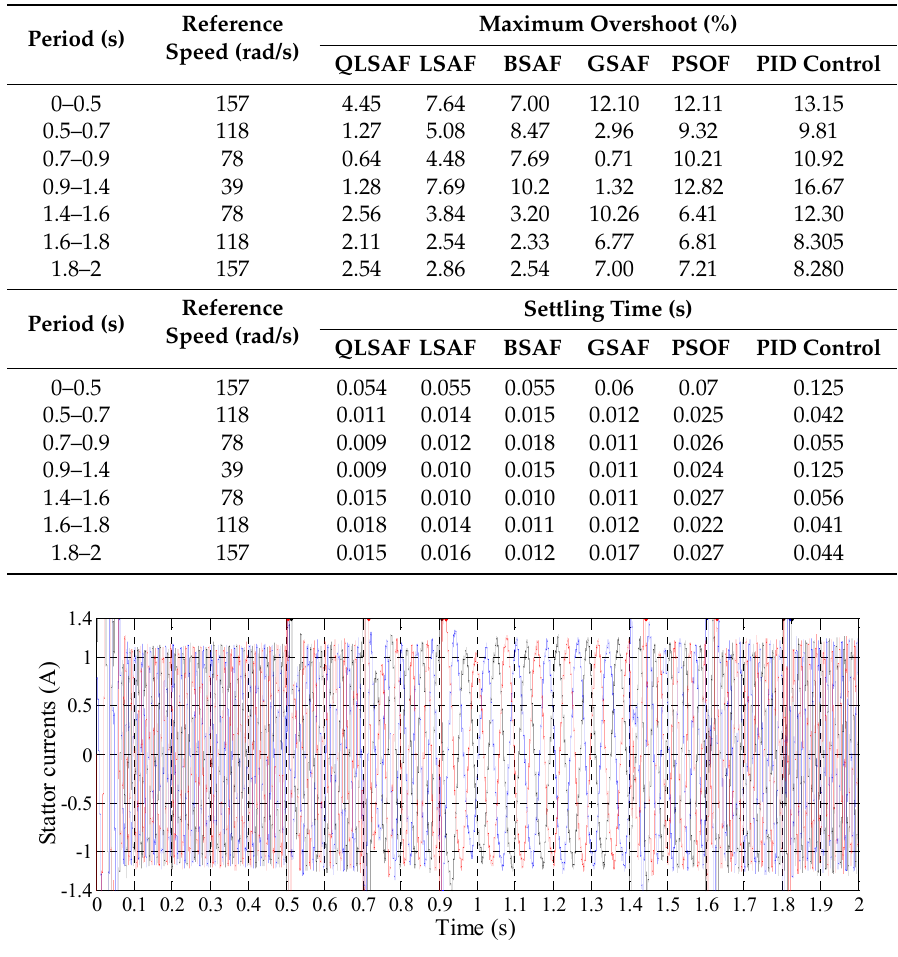
Table 11. Detailed speed response to changes in the reference speed. QLSA-based FLC: QLSAF; LSA-based FLC: LSAF, BSA-based FLC: BSAF, GSA-based FLC: GSAF, PSO-based FLC: PSOF. Proportional integral derivative: PID.